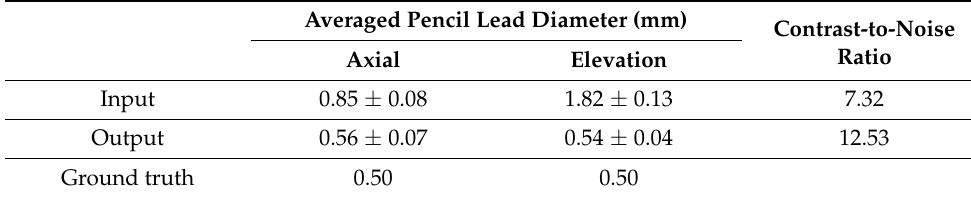
Table 3. Diameter quantification along axial and elevation directions, and the contrast-to-noise ratio of pencil leads.